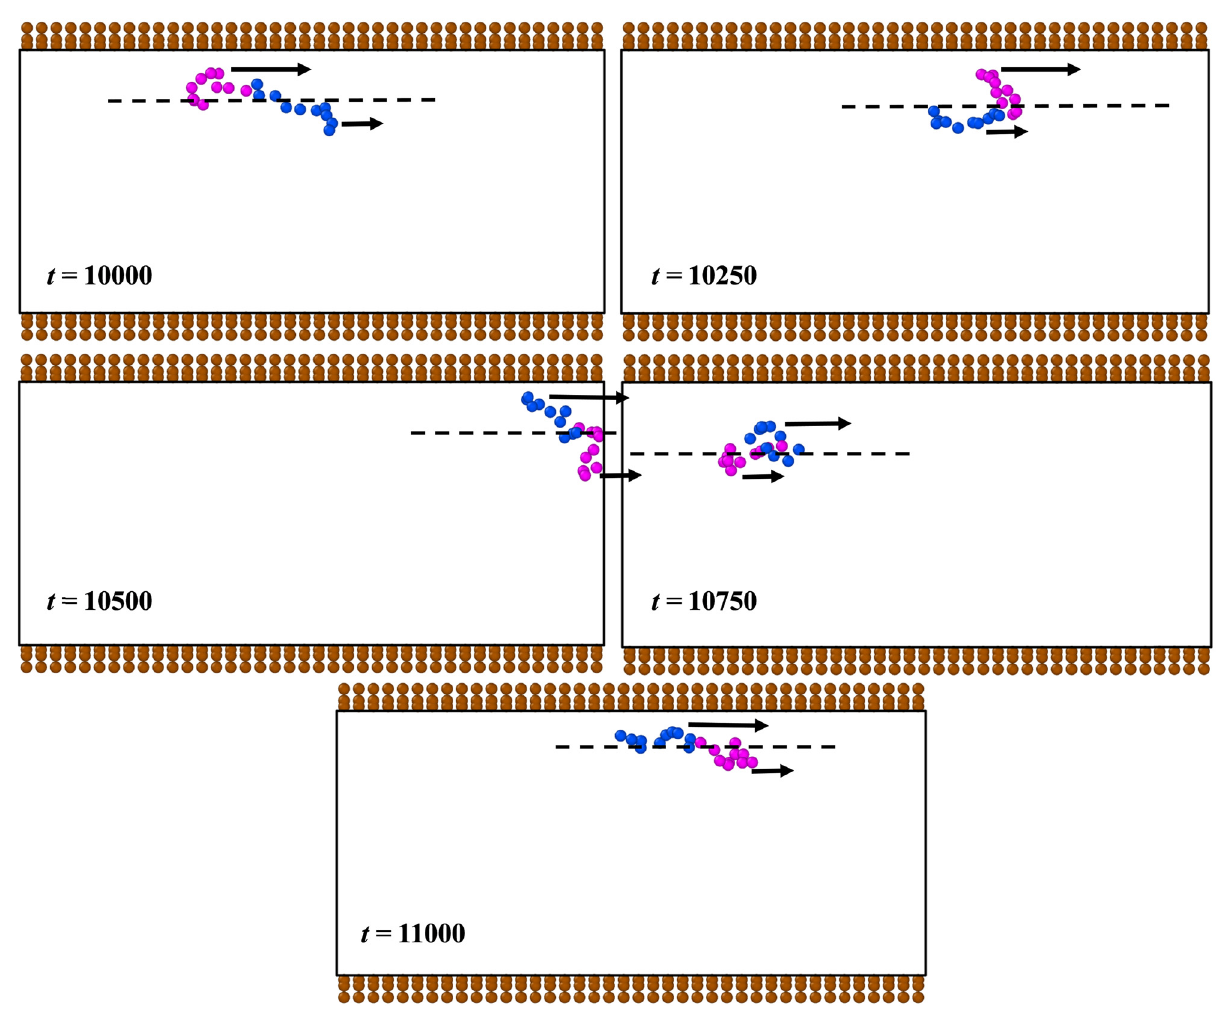
Figure 12: Snapshots of the conformation of a wormlike chain near the wall at t = 10,000, 10,250, 10,500, 10,750, and 11,000 for the driving force f = 0.1, where the arrows in each snapshot denote the shear rate ( i.e., the shear stress )